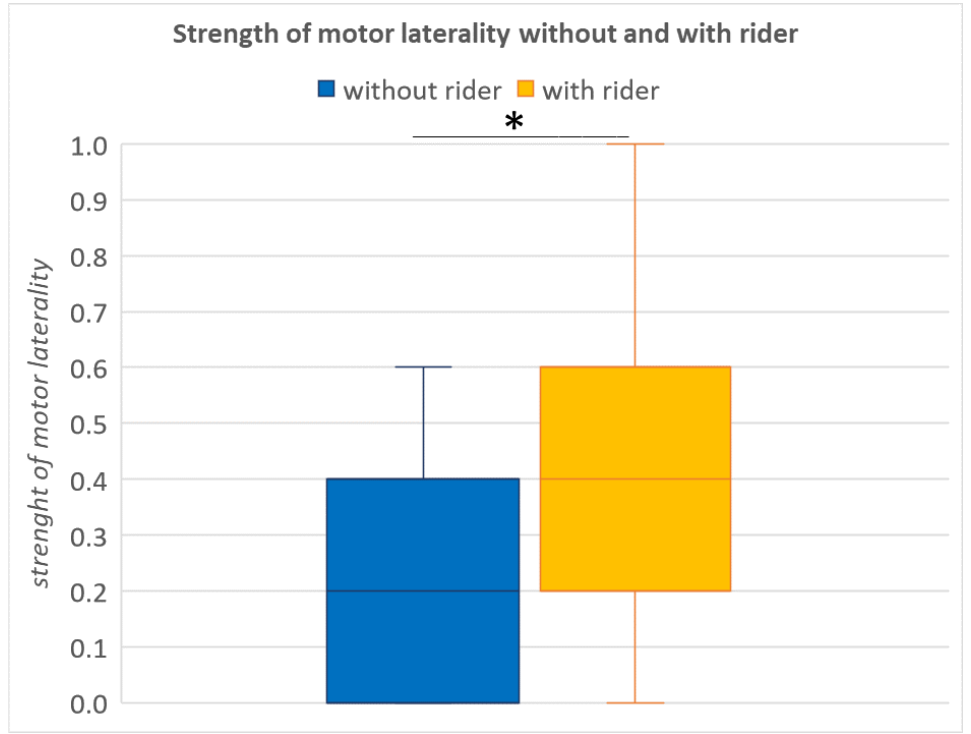
Figure 5. Strength of motor laterality increased significantly when a rider was on the horse (GLM: n = 23, t = 2.68, p = 0.01). The * visualises a statistical significance between p = 0.05 and p = 0.01.